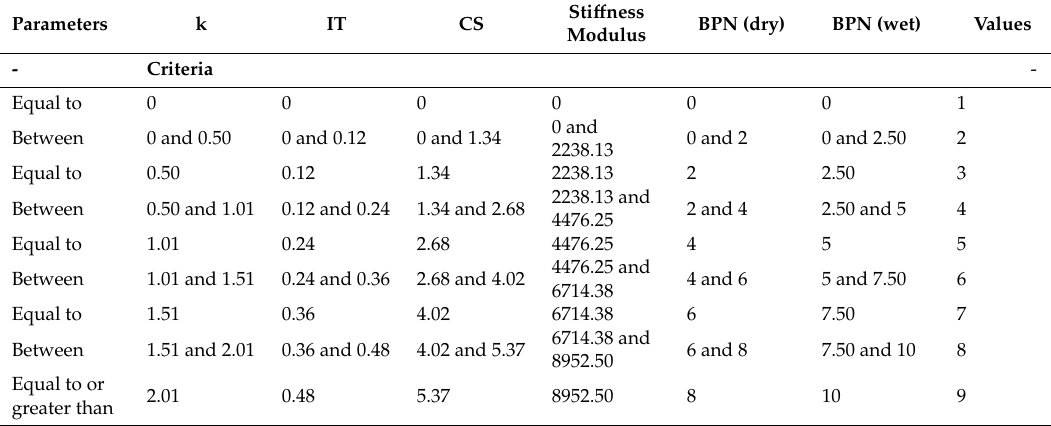
Table 4. Values of Importance employed for the Analytical Hierarchy Process (AHP) multi-criteria decision-making